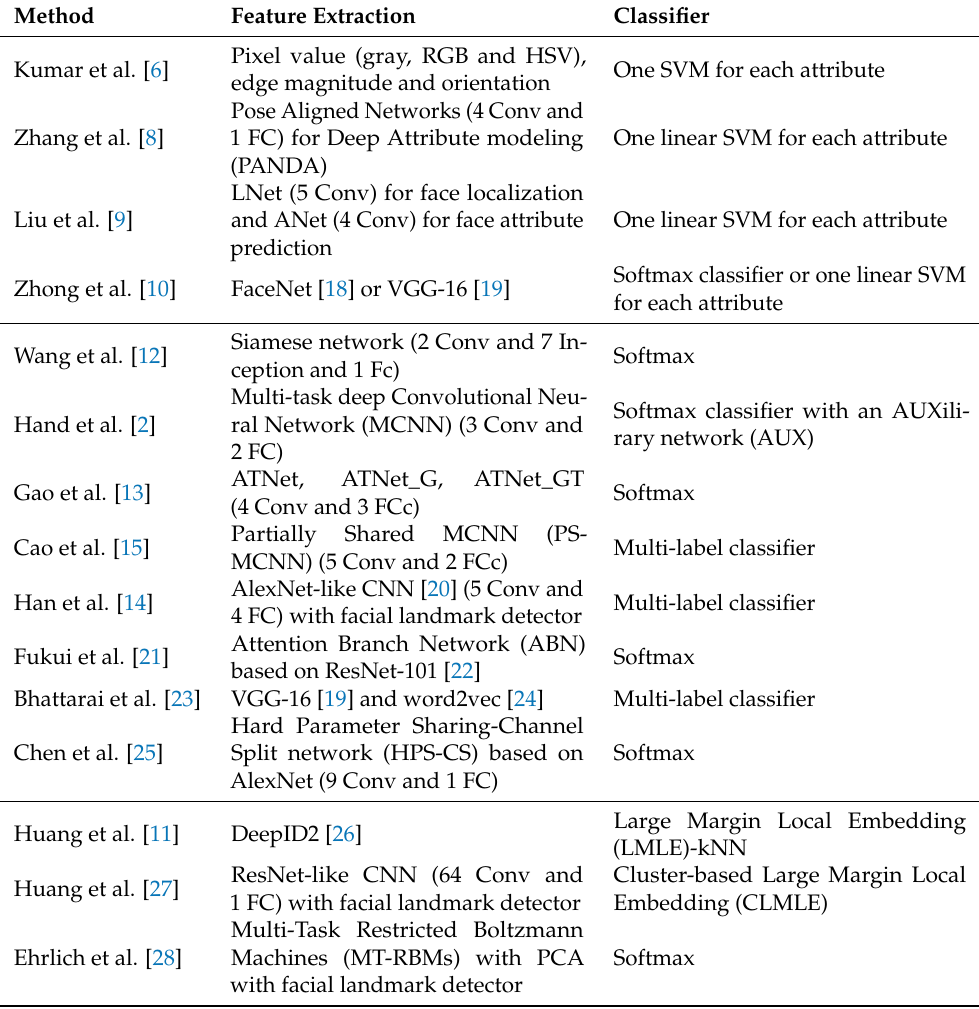
Table 1. A summary of face attribute estimation